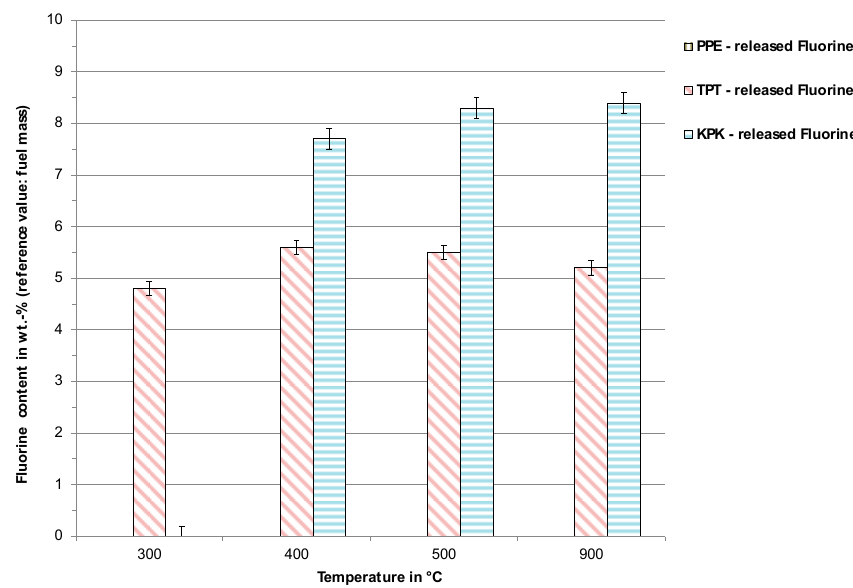
Figure 4. Pyrolysis results of fluorine transfer into the gas phase from PPE, TPT, and KPK.